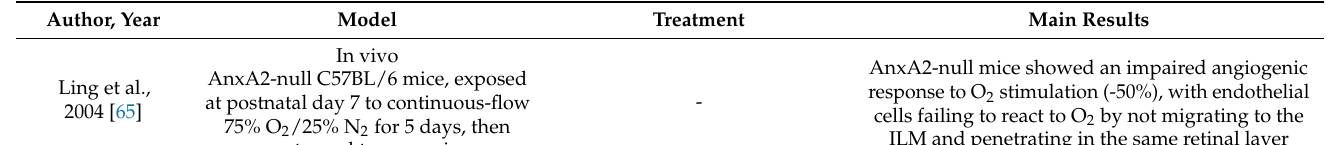
Table 4. Annexins and retinal